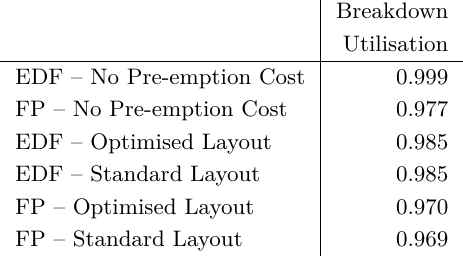
Table 2 Breakdown utilisation under the different approaches for the single PapaBench taskset.